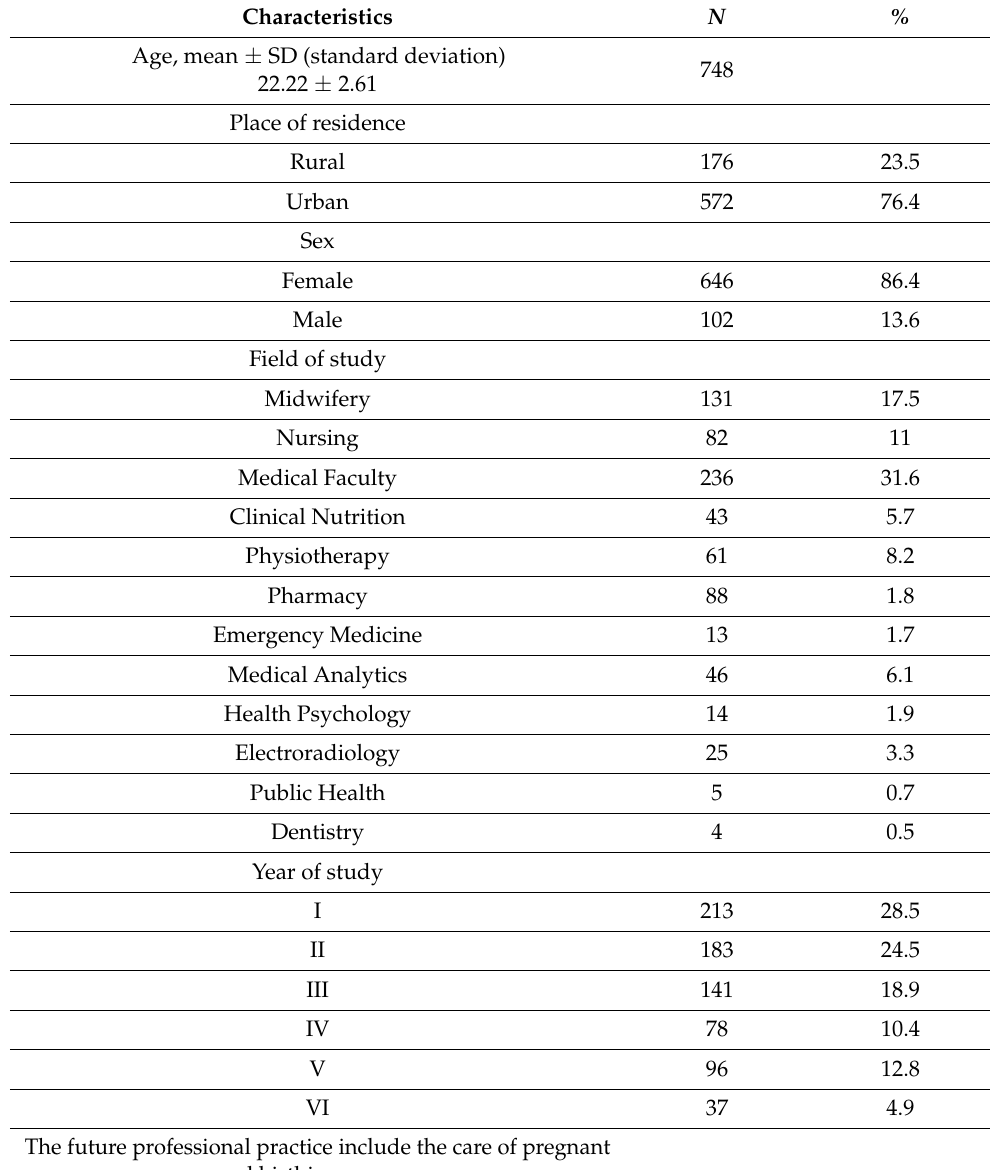
Table 1. Characteristics of the group/general information about the